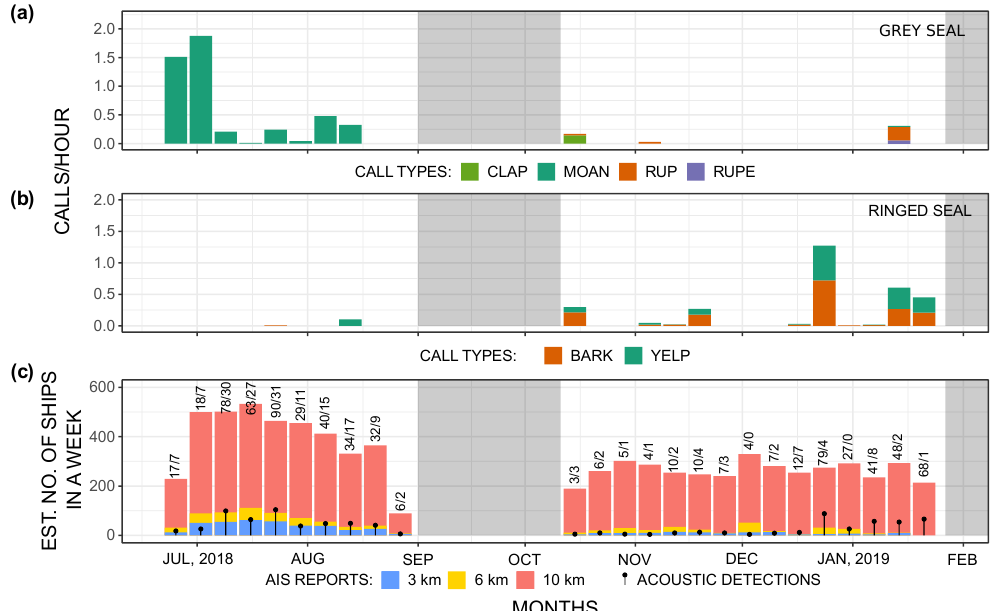
Figure 11. Biophony of ( a ) grey seals and ( b ) ringed seals calls that are detected in the Moonsund monitoring location. The high detection rates of the two pinniped species occurred during two separate seasons. Shown in ( c ) are the coloured bar charts of the number of ships along with their respective distances based on AIS data. The total numbers of detections are shown with a lollipop chart along with the labels. The lollipop chart reveals that the ship noise was detected throughout the year and most frequently during the summer. The rates also start to increase in winter due to the extension of sound propagation ranges. Furthermore, the number of detection relates to no-AIS ships present in the labels. All data is presented on a weekly